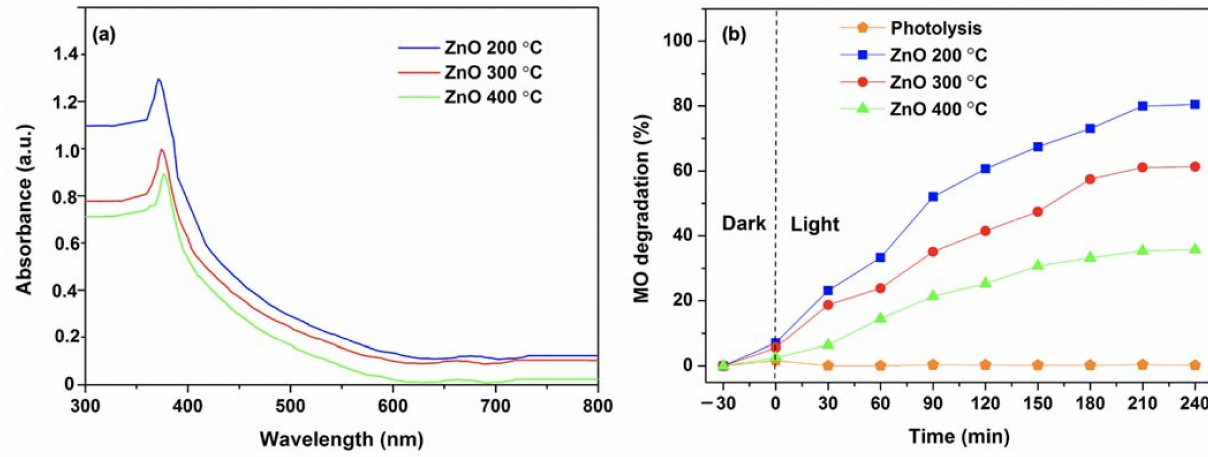
Figure 2. ( a ) UV − Vis spectra; and ( b ) MO degradation efficiency of ZnO NPs at different calcination temperatures (200, 300 and 400 ◦ C) under UV light